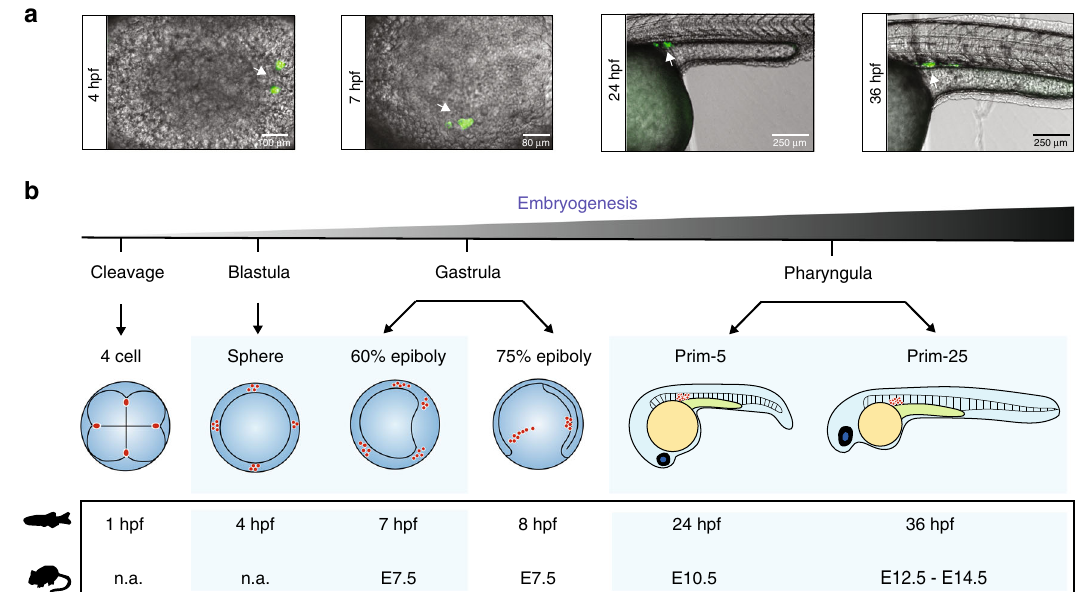
Fig. 1 Zebra fi sh germline development. a Fluorescence microscopy imaging of zebra fi sh kop-EGFP-F'-nos3 - ′ UTR-cry-DsRed transgenic embryos at 4, 7, 24, and 36 hpf (h post fertilisation). b A schematic representation of stages of germline development in zebra fi sh. At the four-cell stage, germ plasm (red circles) localises to the four cleavage furrows. At 4 hpf (sphere), four clusters of primordial germ cells (PGCs) (red circles) are easily identi fi able. In the gastrula stage embryo, four clusters of PGCs start to migrate dorsally. By the pharyngula stage, PGCs have completed their migration and are located between the 8th and the 10th somite